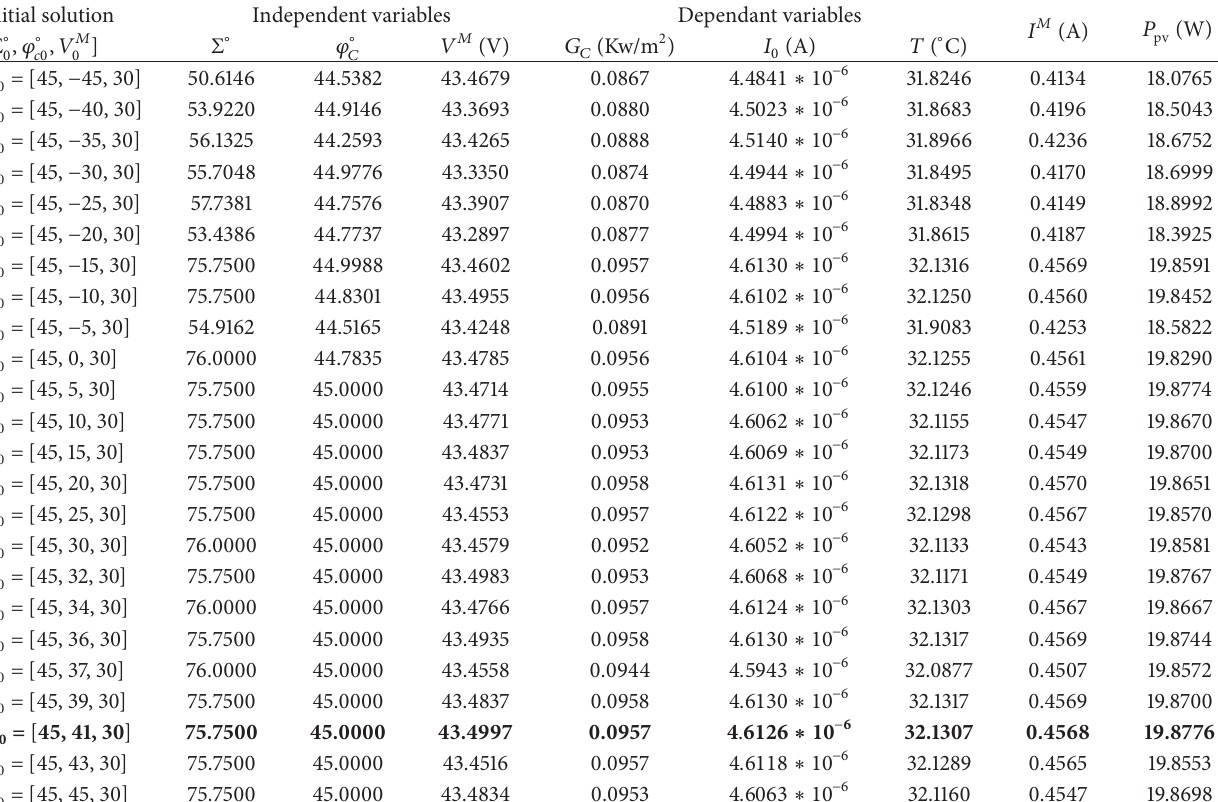
Table 3: Effect of changing the initial collector azimuth angle on the module power at